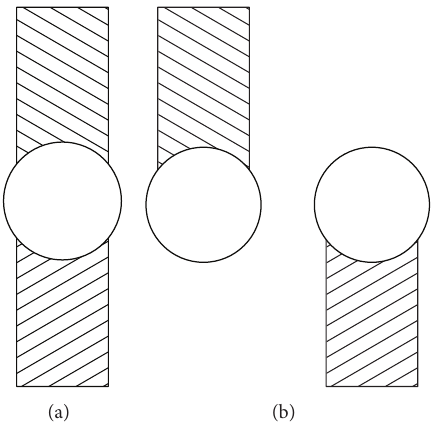
Figure 1: Illustration of the stimulus and the arrangement of the Polaroid filters in Experiment 1.